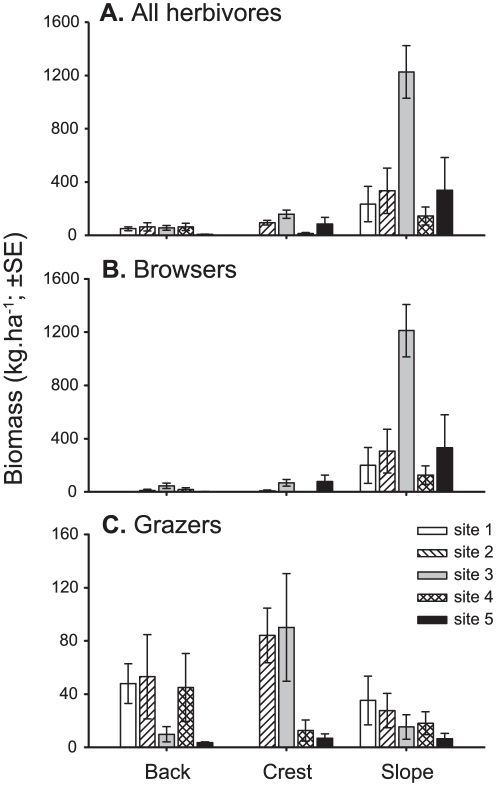
Spatial variation in herbivorous fish biomass on Lord Howe Island.Variation in (A) all roving herbivorous fishes, (B) macroalgal browsing fishes, and (C) grazing fishes among three habitats and five sites on Lord Howe Island. Each mean is based on six 50-m belt transects. Note the difference in the y-axis scales for the two functional groups.